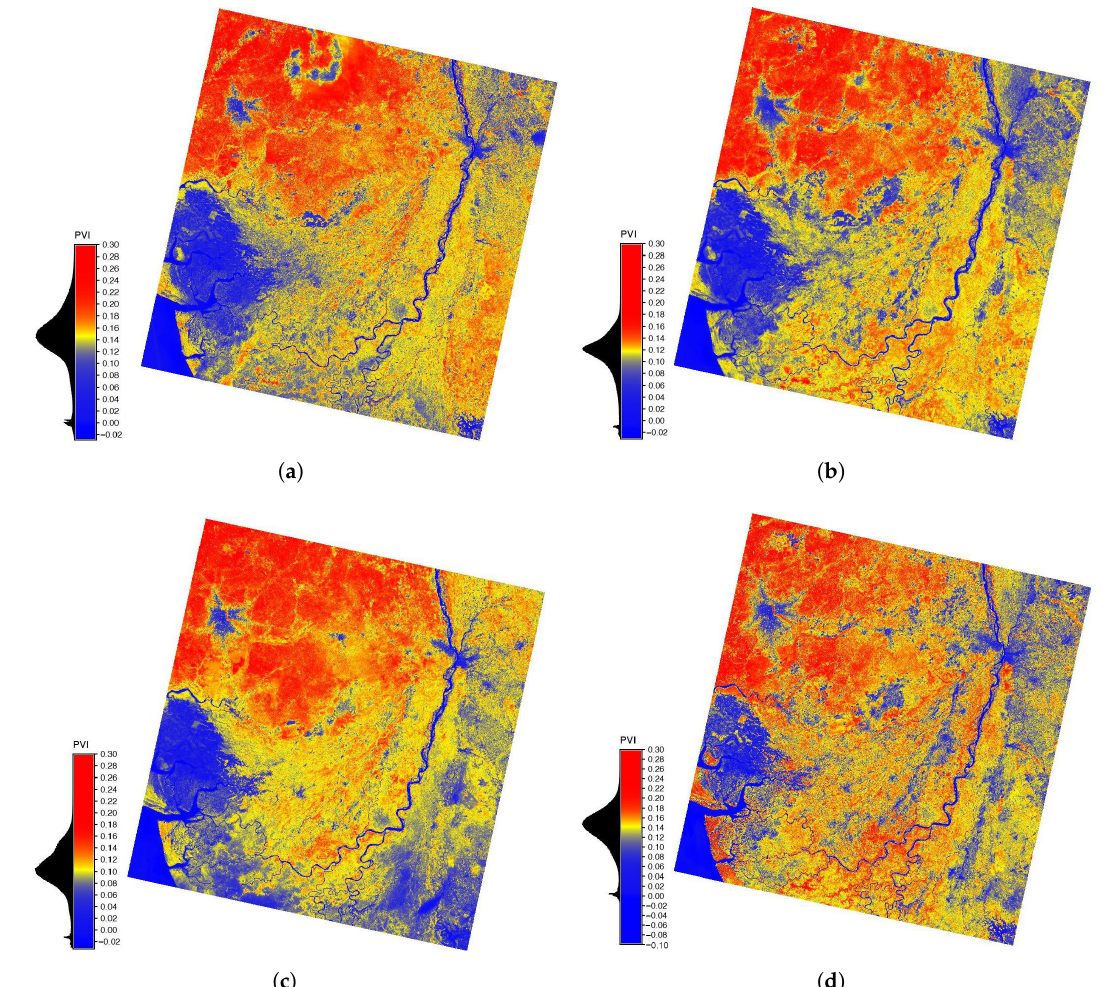
Figure 7. PVI computed from the Landsat 8-9 OLI/TIRS images of Niger River Delta for four years: ( a ) 2013, ( b ) 2015 ( c ) 2021, ( d )